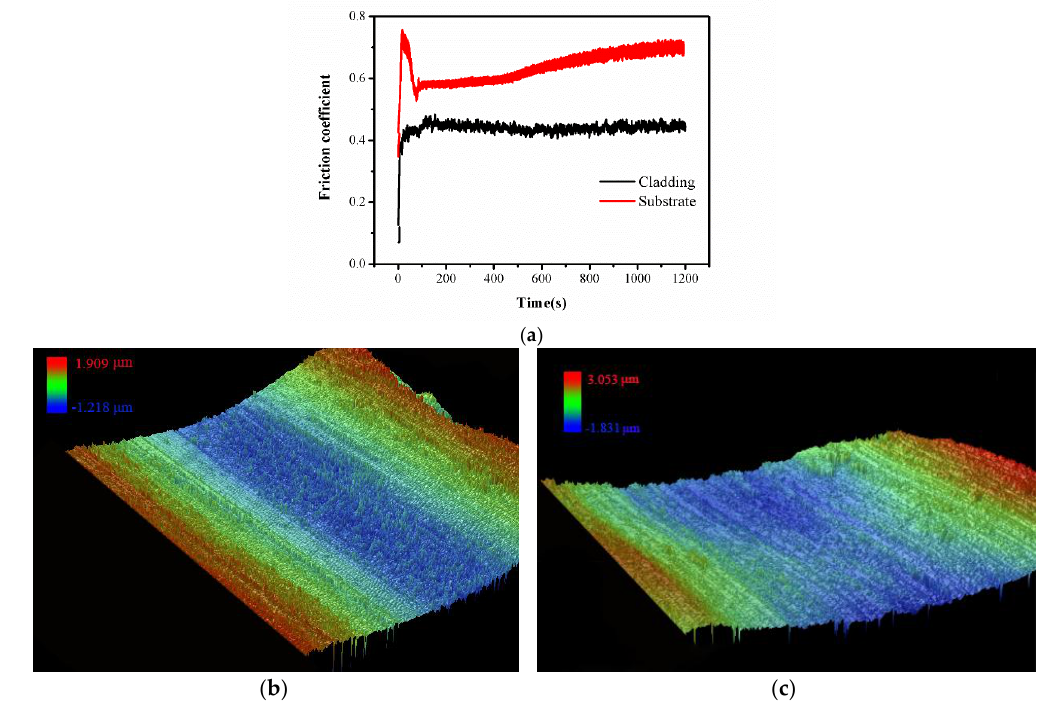
Figure 9. ( a ) Friction coefficient curve of top cladding layer and substrate; ( b ) Wear on the cladding layer; ( c ) Wear on the substrate.